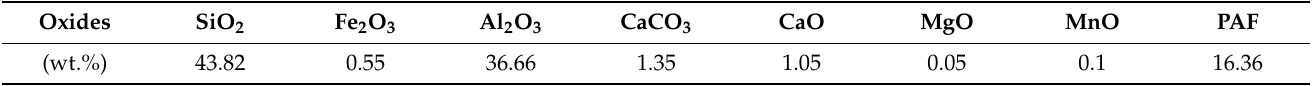
Table 1. The chemical composition (wt.%) of natural kaolin (derived from XRF analysis). Oxides